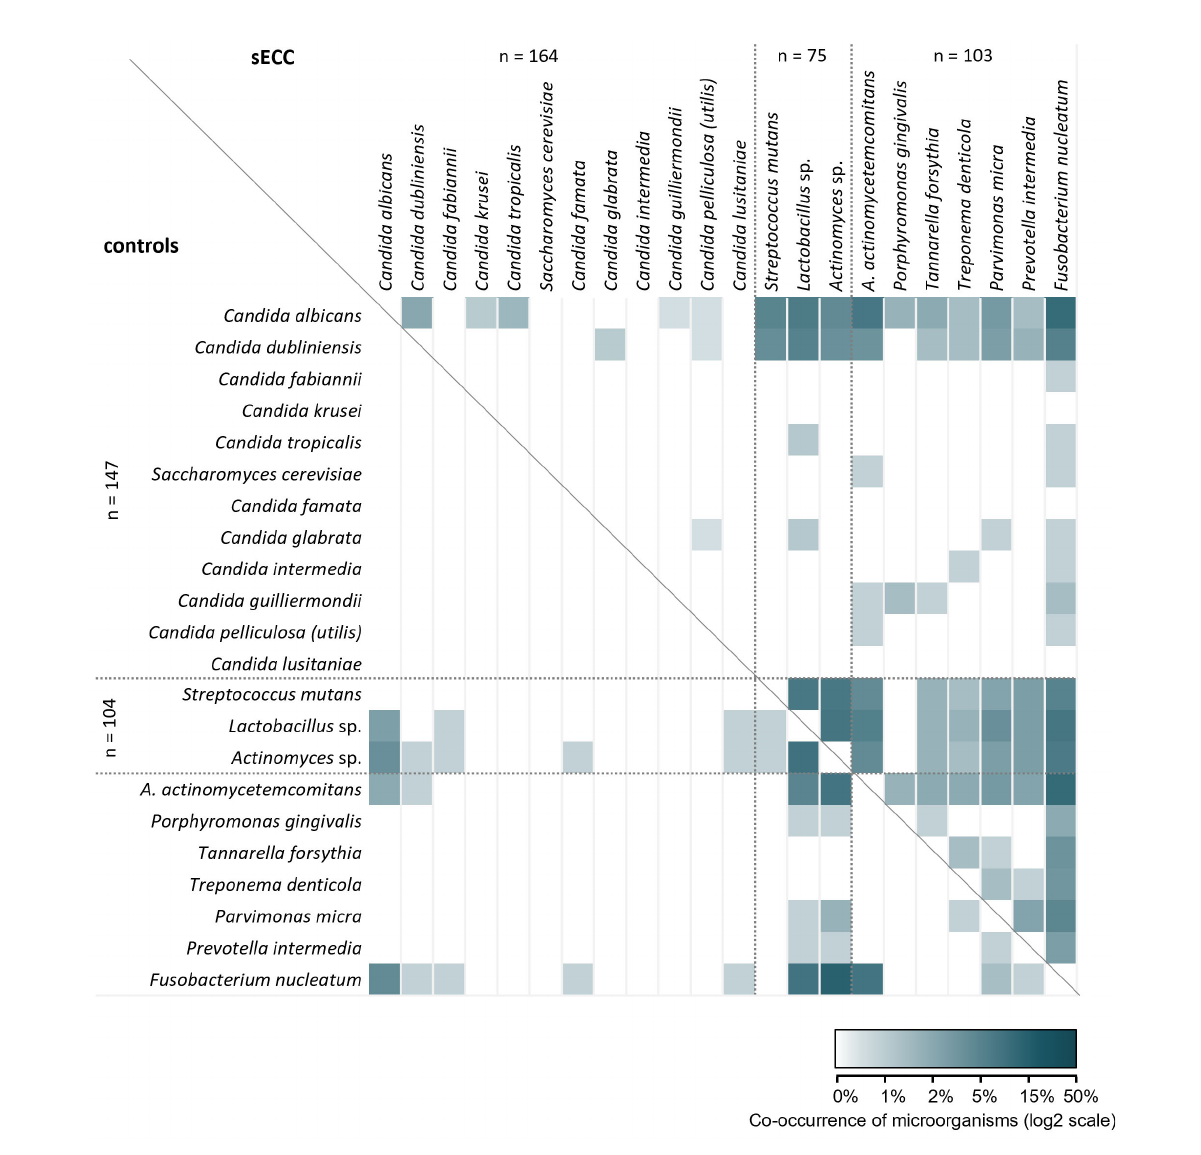
FIGURE 3 Microbial co-occurrence of Candida spp., selected cariogenic and periodontal bacteria in the groups of children with severe early childhood caries (sECC) and controls. Combinations for children with sECC are shown above the diagonal line, those for controls are below the line. A. actinomycetemcomitans , Aggregatibacter actinomycetemcomitans